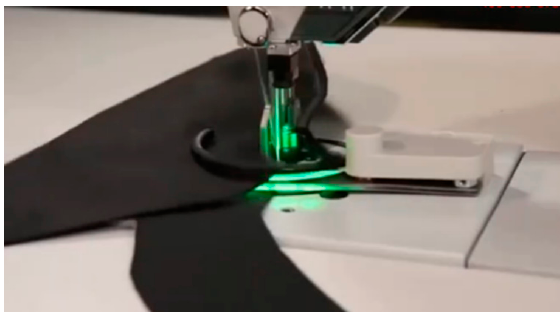
Figure 7. Automatic sewing.